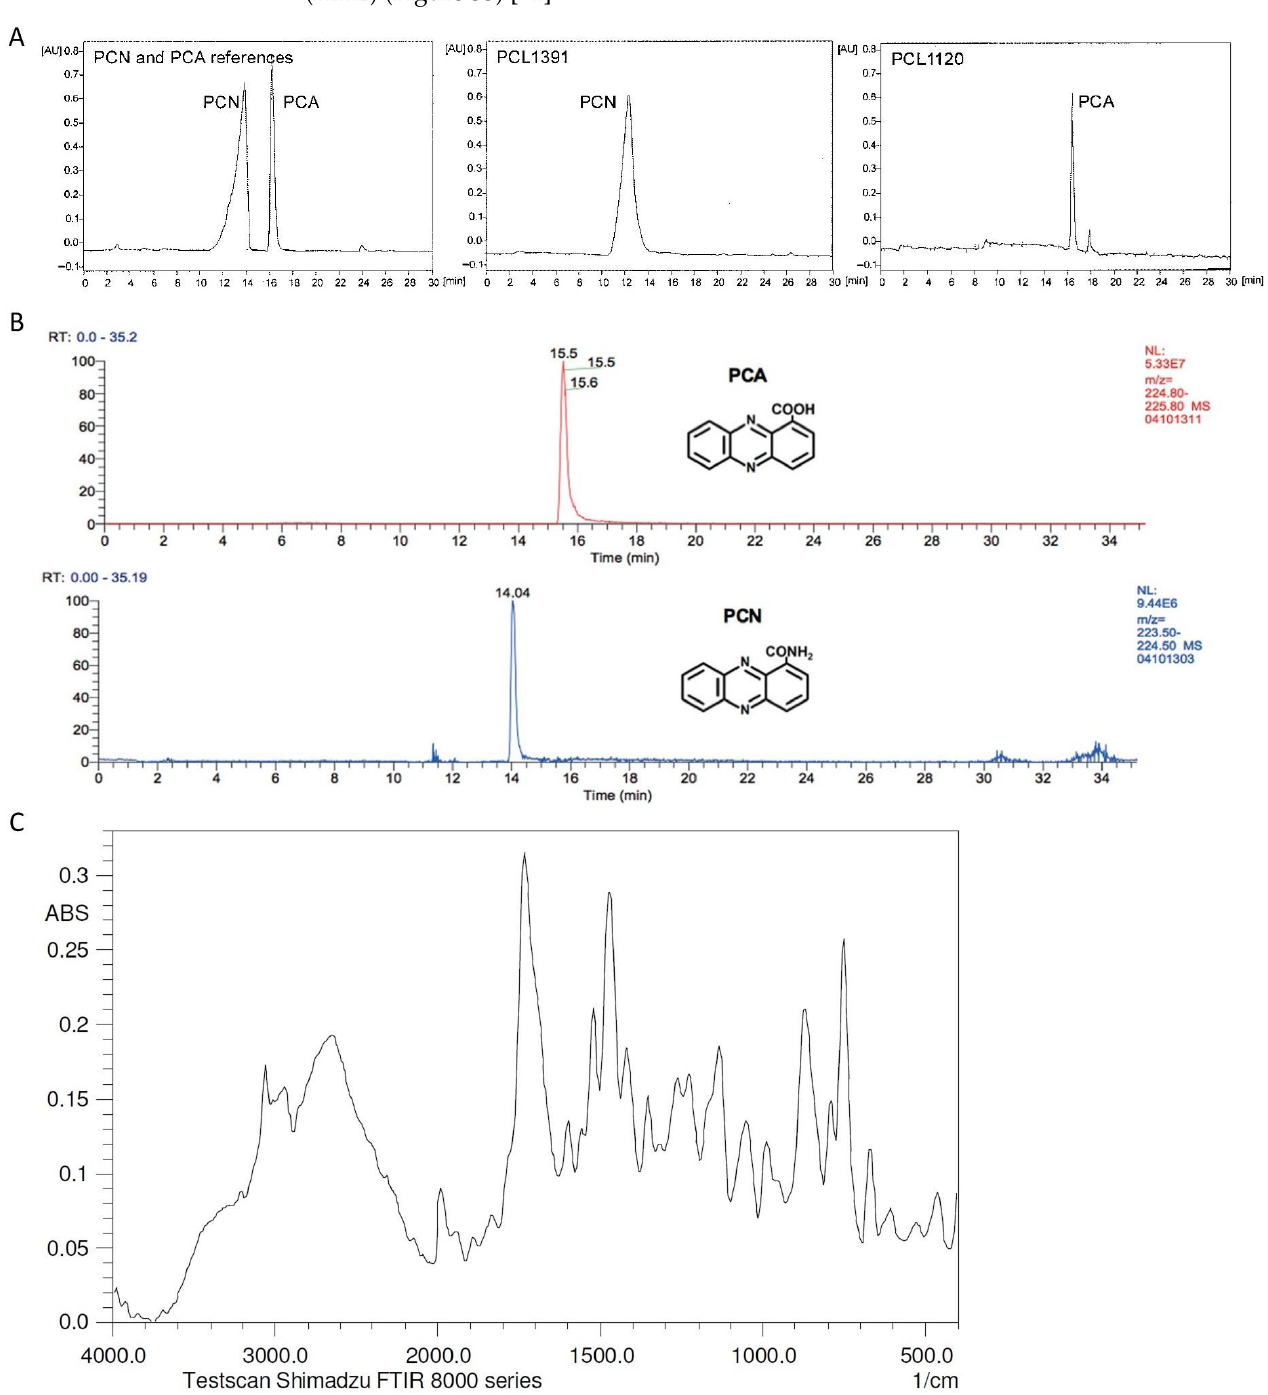
Figure 5. Spectra of different characterization analyses of phenazines, ( A ) Phase-reverse HPLC chromatogram of PCA and PCN [49]; ( B ) PCA and PCN peaks detected by LC-MS [18]; ( C ) FTIR spectrum of crystalline PCA [76].